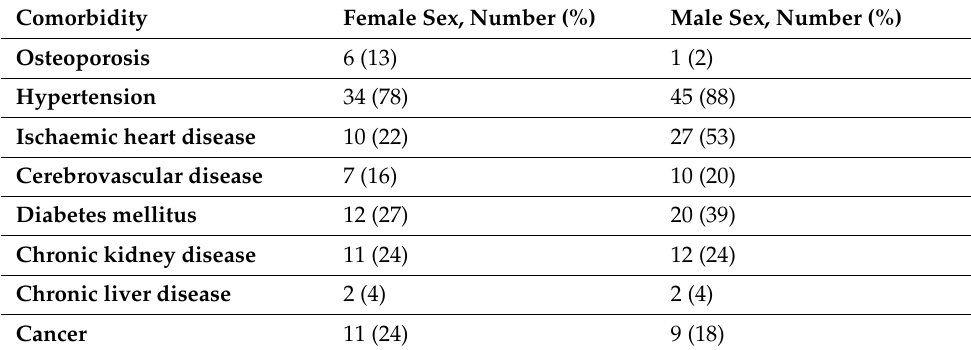
Table 4. Comorbidities by sex (Female, n = 45) (Male, n =